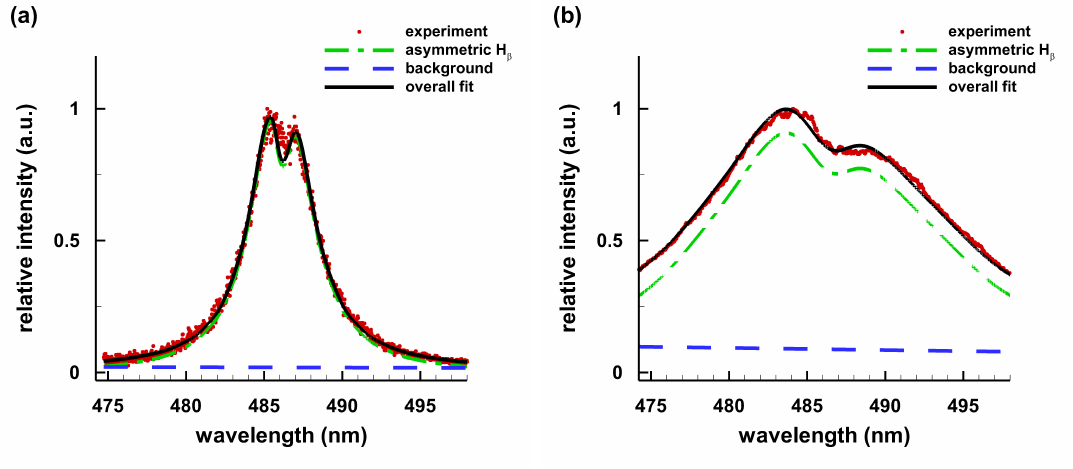
Figure 2. H β line-of-sight spectra: ( a ) τ = 650 ns, N e = 1.4 × 10 17 cm − 3 , H 2 gas pressure of 1.06 × 10 5 Pa [23]; and ( b ) τ = 100 ns, spectral resolving power 24,000 or resolution of 0.02 nm, N e = 8.6 × 10 17 cm − 3 , H 2 gas pressure of 1.32 × 10 5 Pa